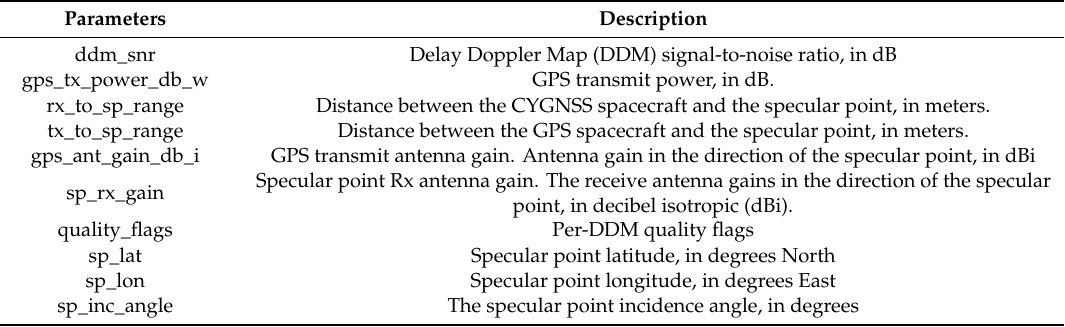
Table 2. The Cyclone Global Navigation Satellite System (CYGNSS) data source parameters. Parameters